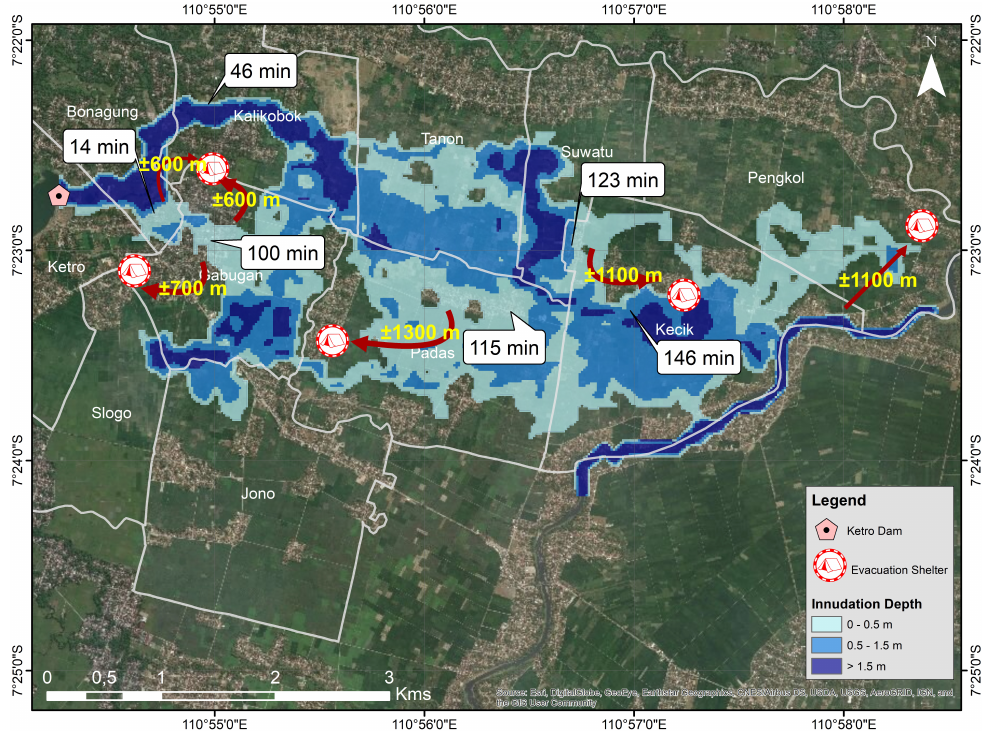
Figure 16. Numerical result for the maximum inundation area, the flood arrival time, and the length of the evacuation